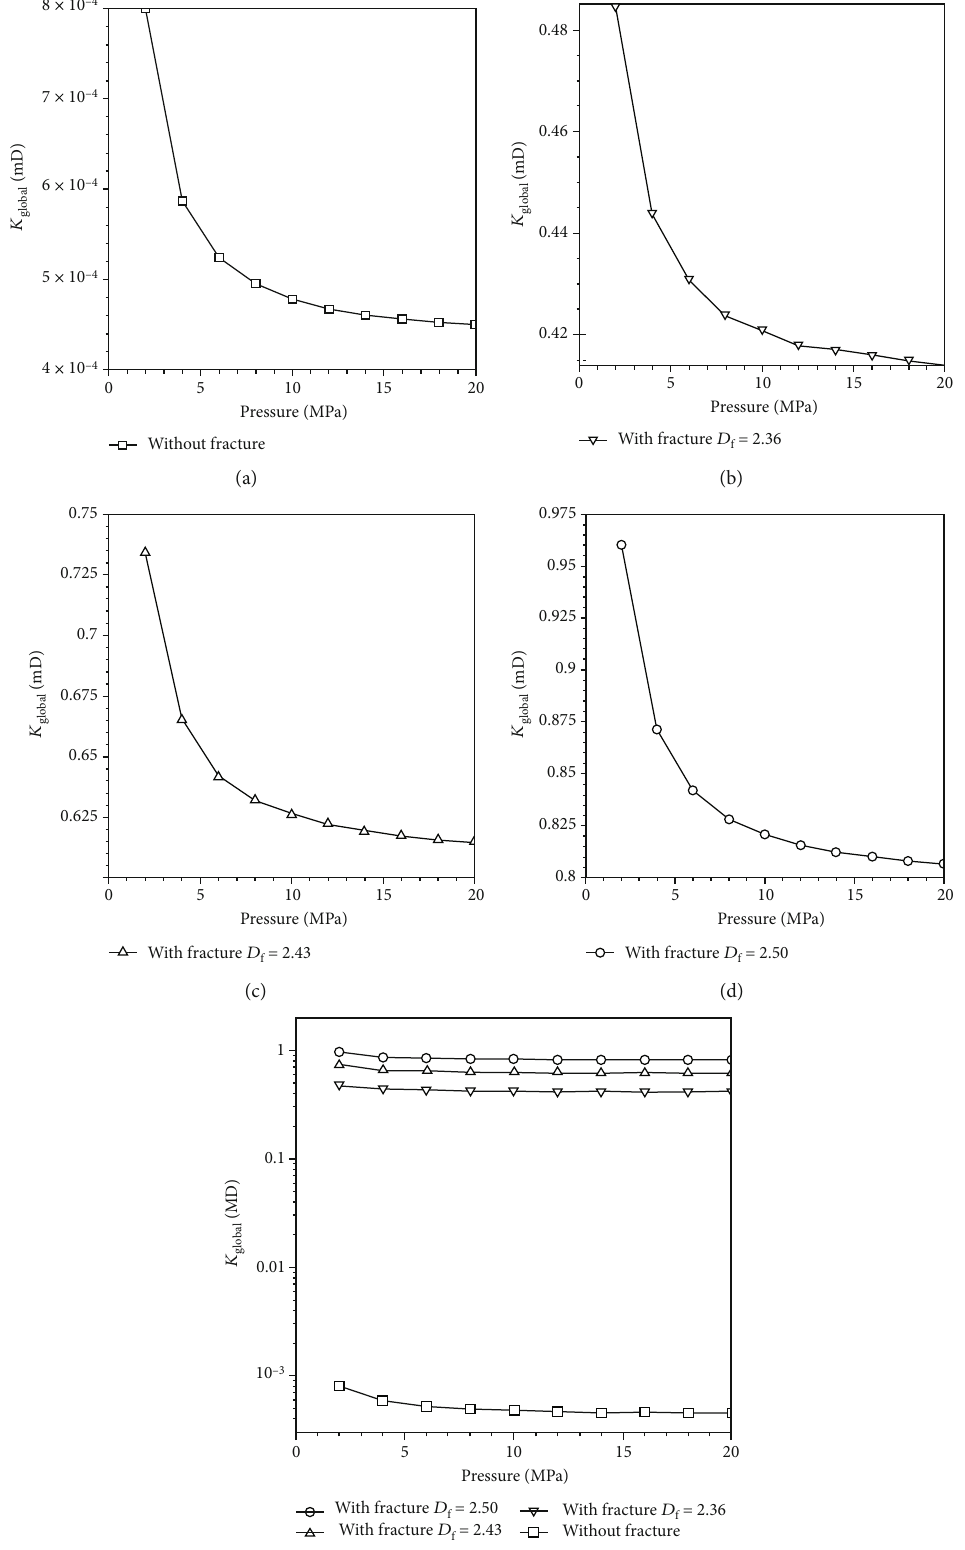
Figure 8: The impact of fracture development on